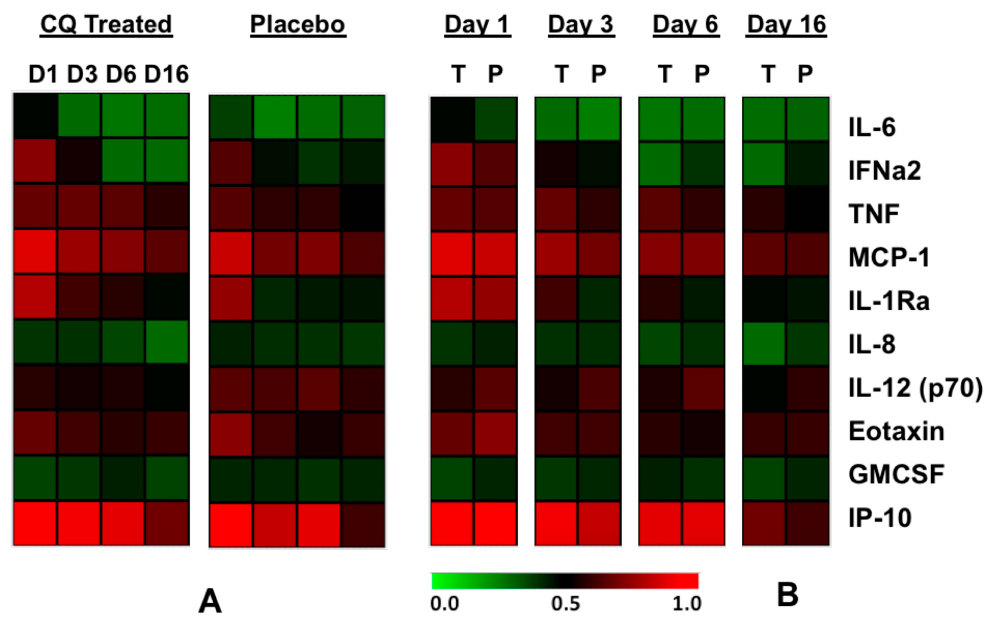
Figure 6. Heatmap of cytokines measured in each group. ( A ) General Comparison of chloroquine (CQ) treated vs Placebo treated groups ( B ) Comparing chloroquine treated (T) vs. Placebo treated (P) groups at each specific day. Heatplots are shown (top down) from the lower quantities (green) to higher quantities (red).